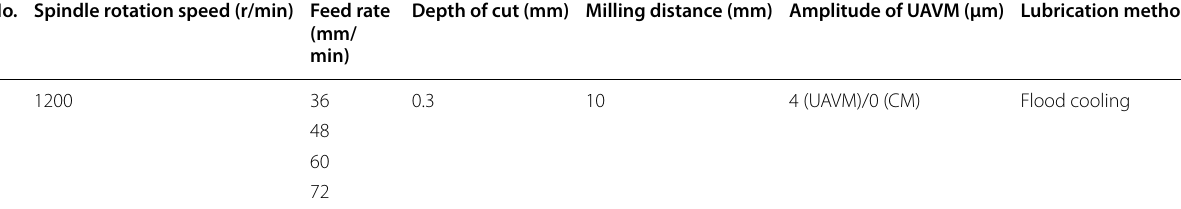
Table 4 Parameters for the UAVM and CM No. Spindle rotation speed (r/min) Feed rate